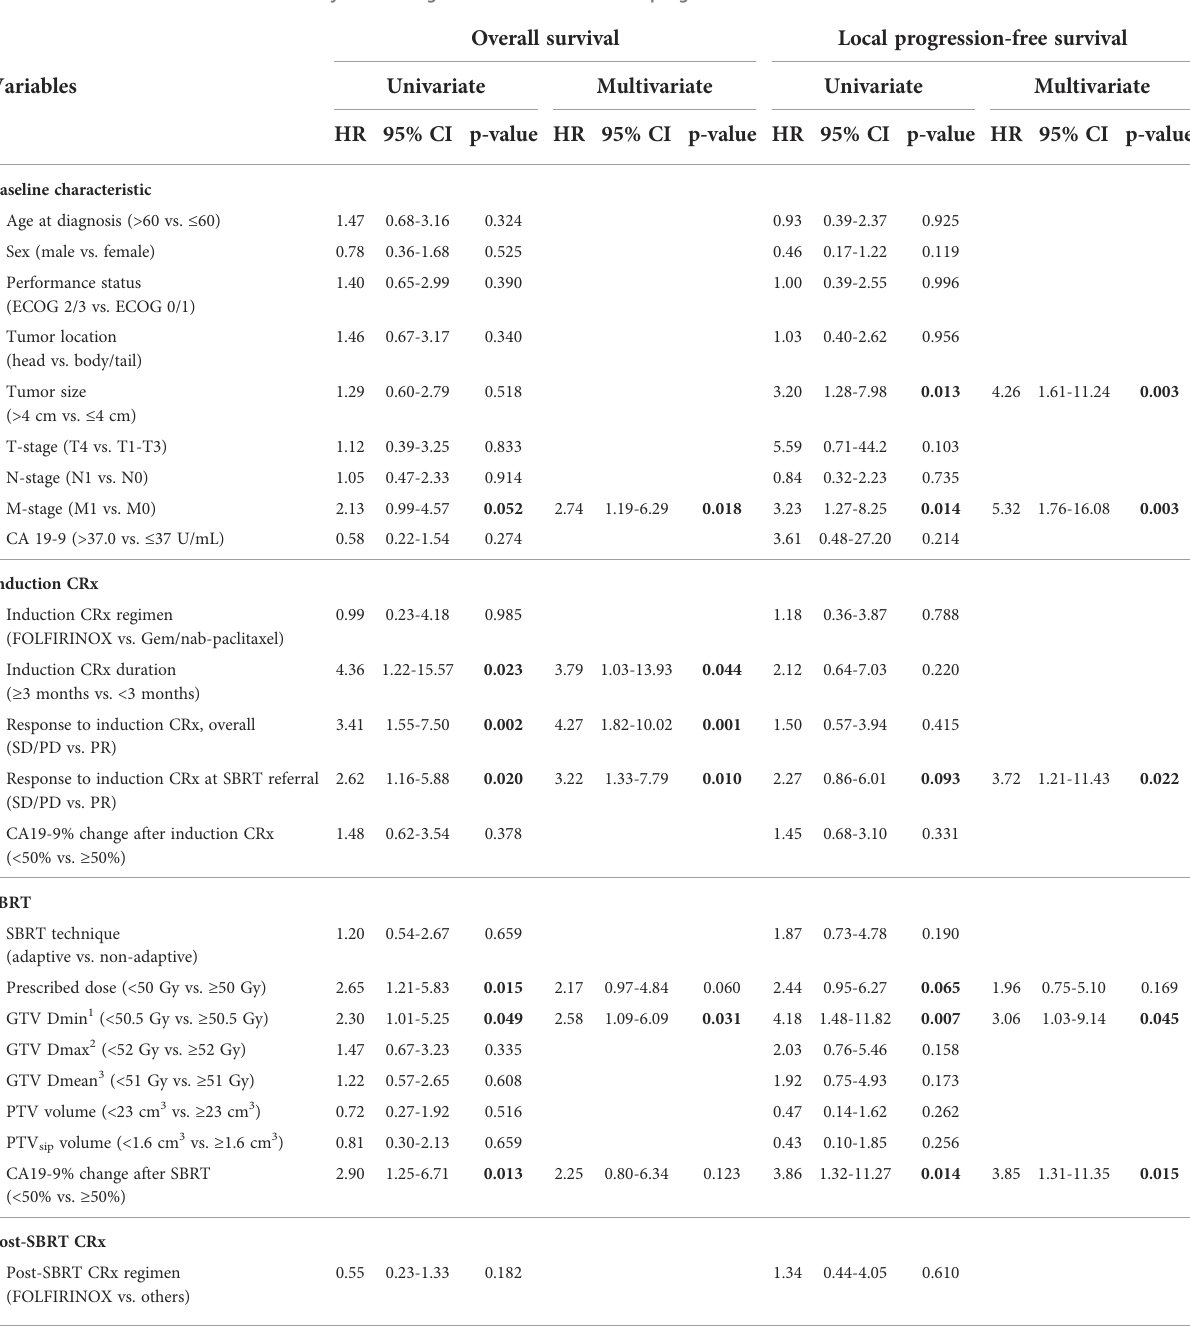
TABLE 2 Univariate and multivariate analysis affecting overall survival and local progression-free survival. Overall survival Local progression-free